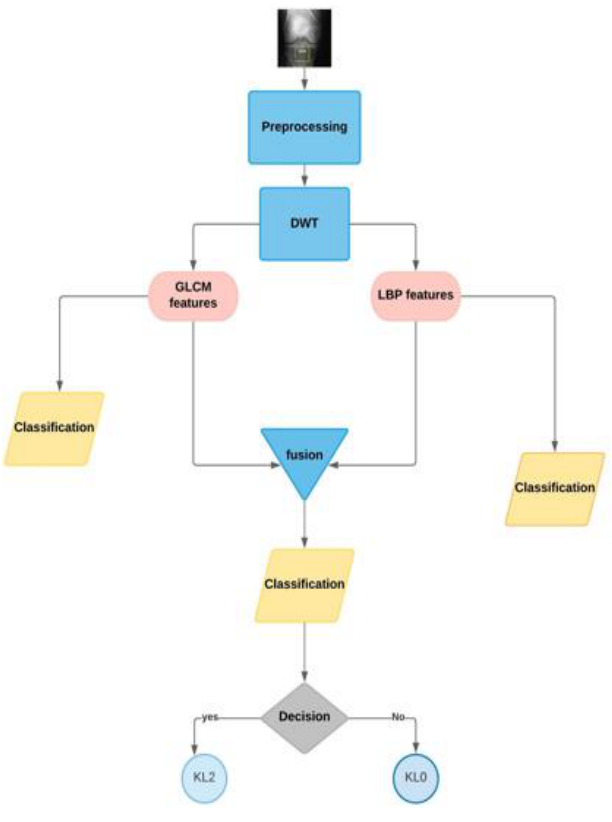
Figure 3. Block diagram of the proposed methodology